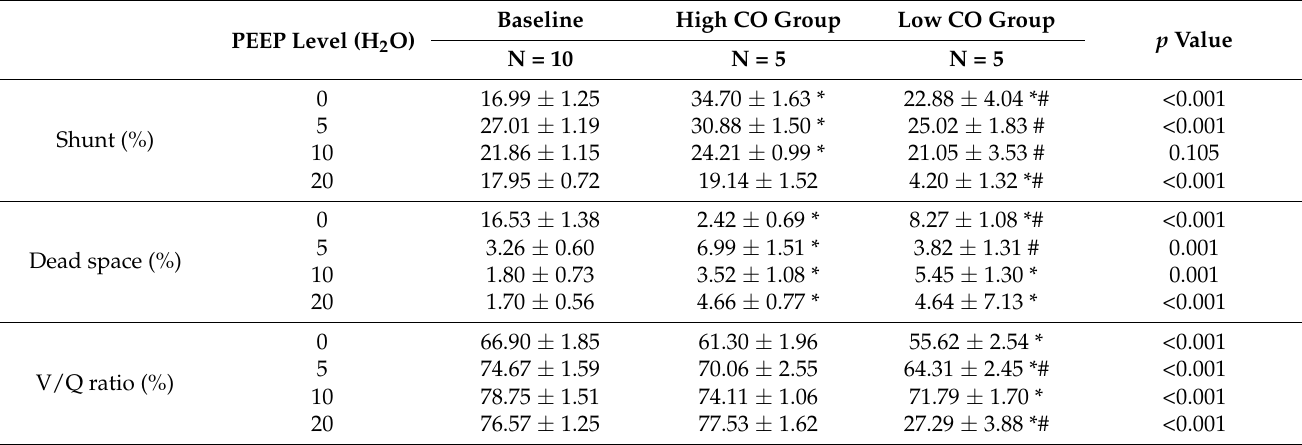
Table 2. Changes in lung shunt, dead space, and ventilation/perfusion (V/Q) ratio under the influence of high/low cardiac output and different PEEPs.